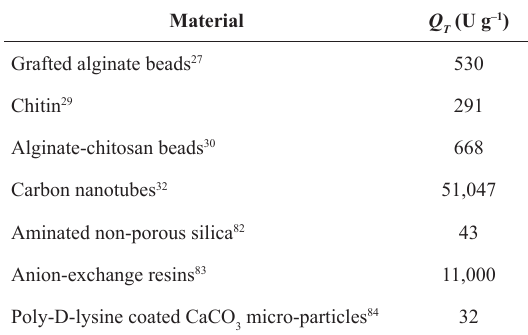
Table 4. Inulinase loading capacity ( Q found in